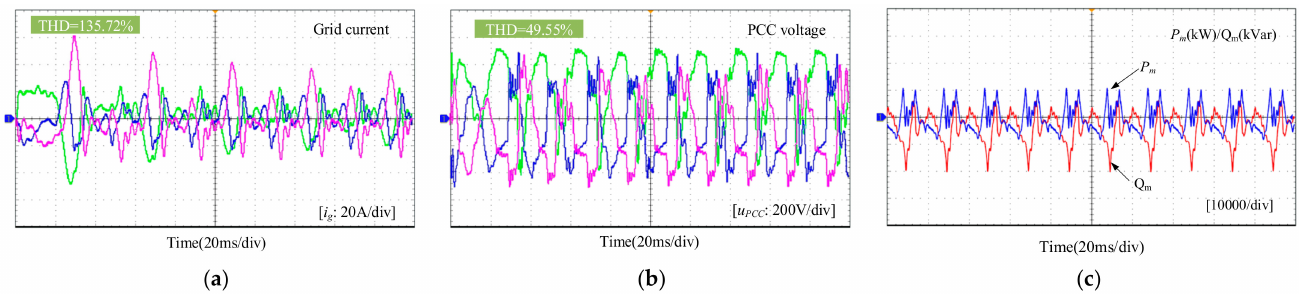
Figure 17. Experiment results with no impedance reshaping control strategy when SCL = 50%. ( a ) Grid current, ( b ) PCC voltage, ( c ) active and reactive